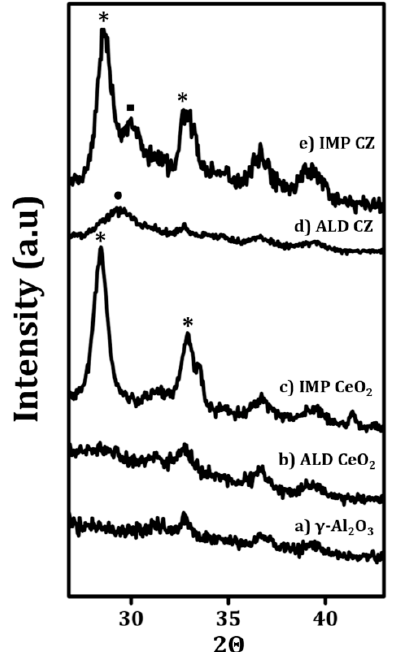
Figure 1. XRD patterns of ( a ) γ -Al 2 O 3 support after calcination to 1173 K in air, and ALD-modified samples, ( b ) 20CeO 2 –Al 2 O 3 and ( d ) 20Ce 0.5 Zr 0.5 O 2 –Al 2 O 3 heated to 1073 K. The patterns in ( c ) and ( e ) were obtained from CeO 2 (IMP)/Al 2 O 3 and CZ(IMP)/Al 2 O 3 respectively. The loadings of materials are the same for the ALD-modified supports and the infiltrated supports. Peaks were normalized to a distinct graphite peak around 2 θ = 26.7 ◦ . Characteristic peaks for ceria–zirconia solid solution are marked by , while peaks for CeO 2 and ZrO 2 are marked by * and (cid:4)